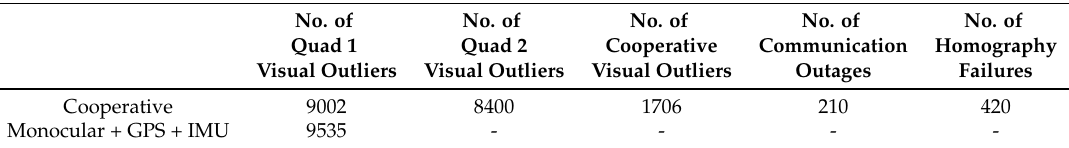
Table 3. Number of failures introduced into the